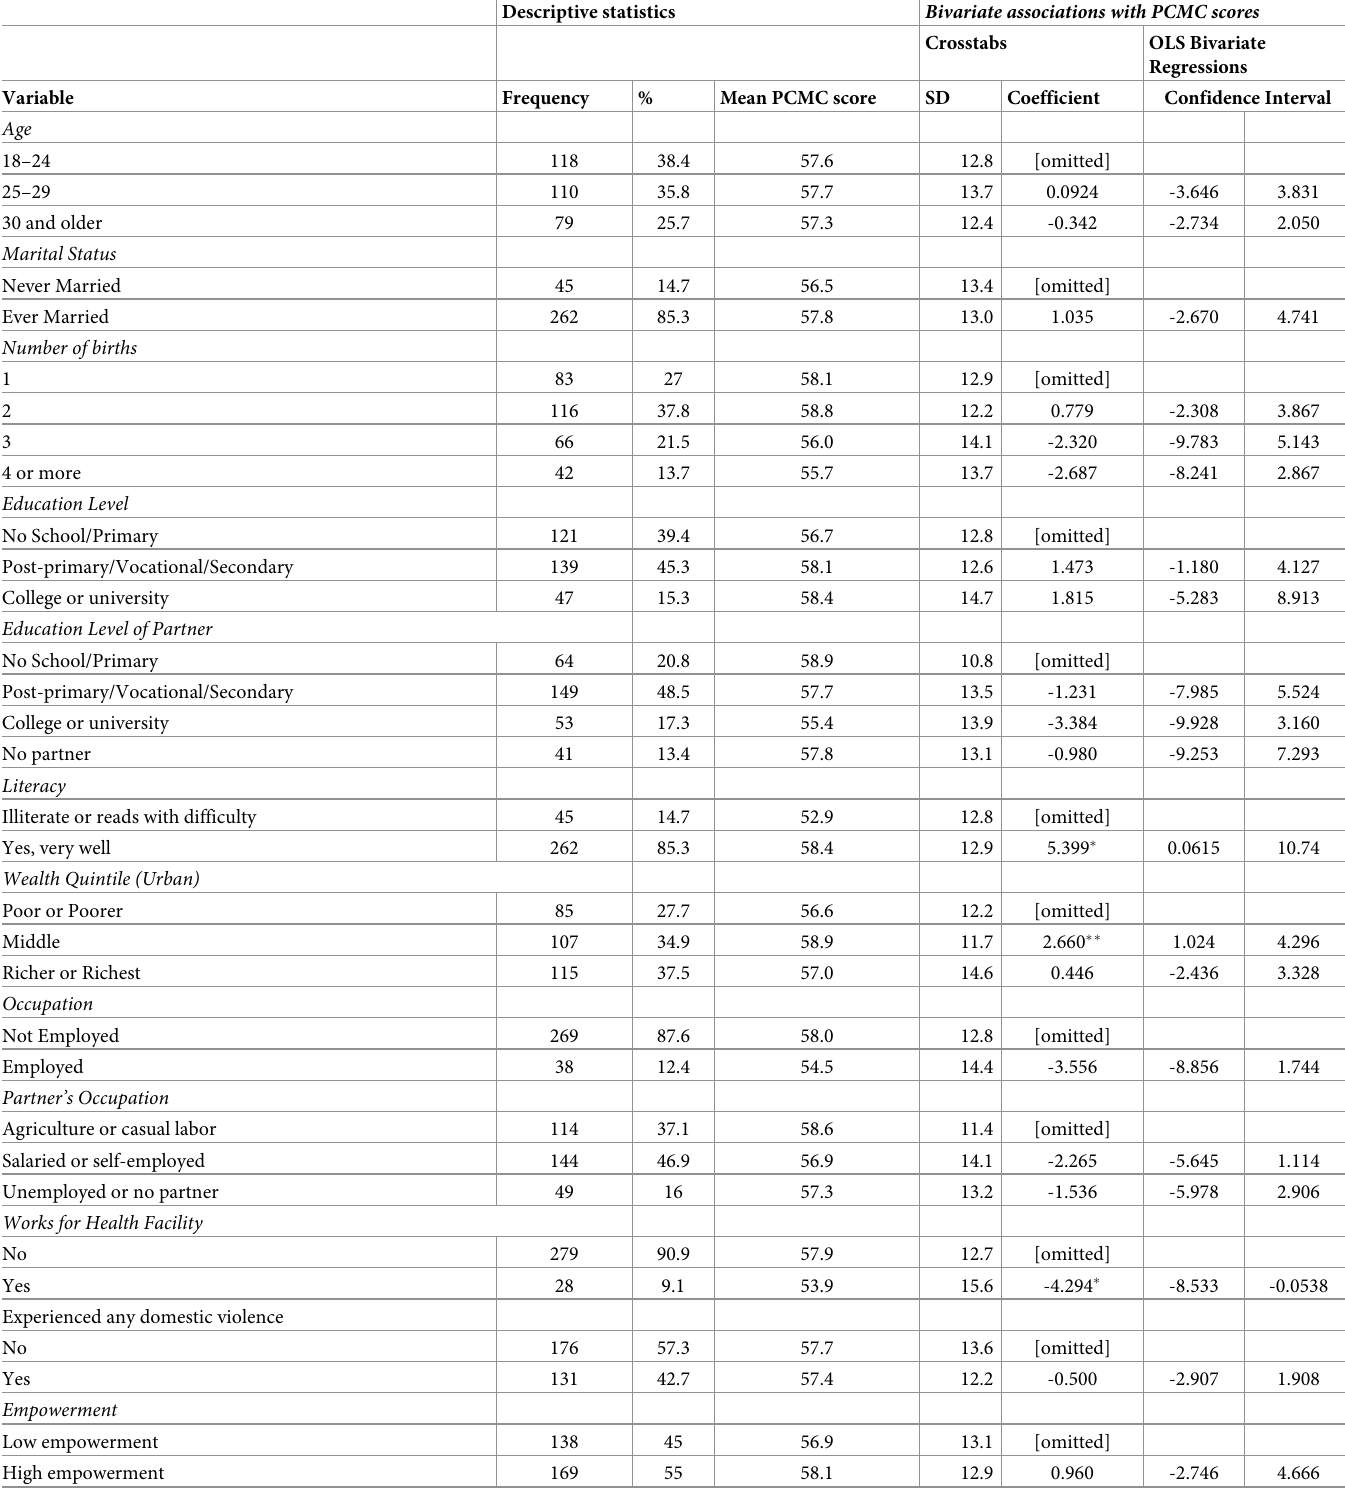
Table 1. Respondent’s sociodemographic characteristics and bivariate associations with PCMC.